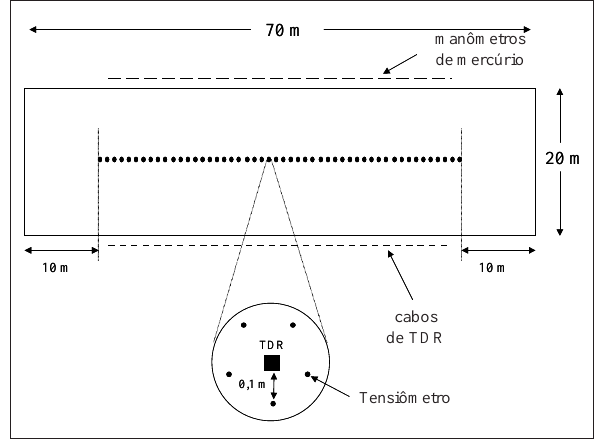
Figura 1. Parcela experimental com a localização dos 50 pontos de observação. O detalhe mostra a configuração de um ponto de observação com TDR e tensiômetros.